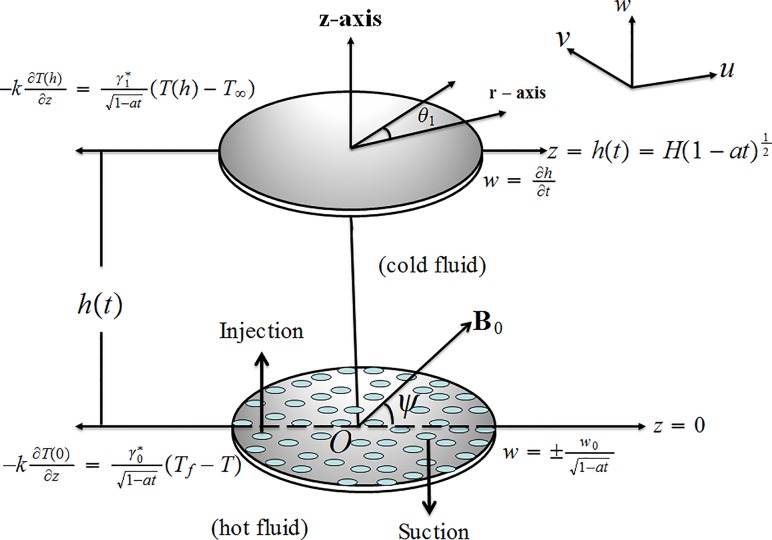
Geometry of problem.